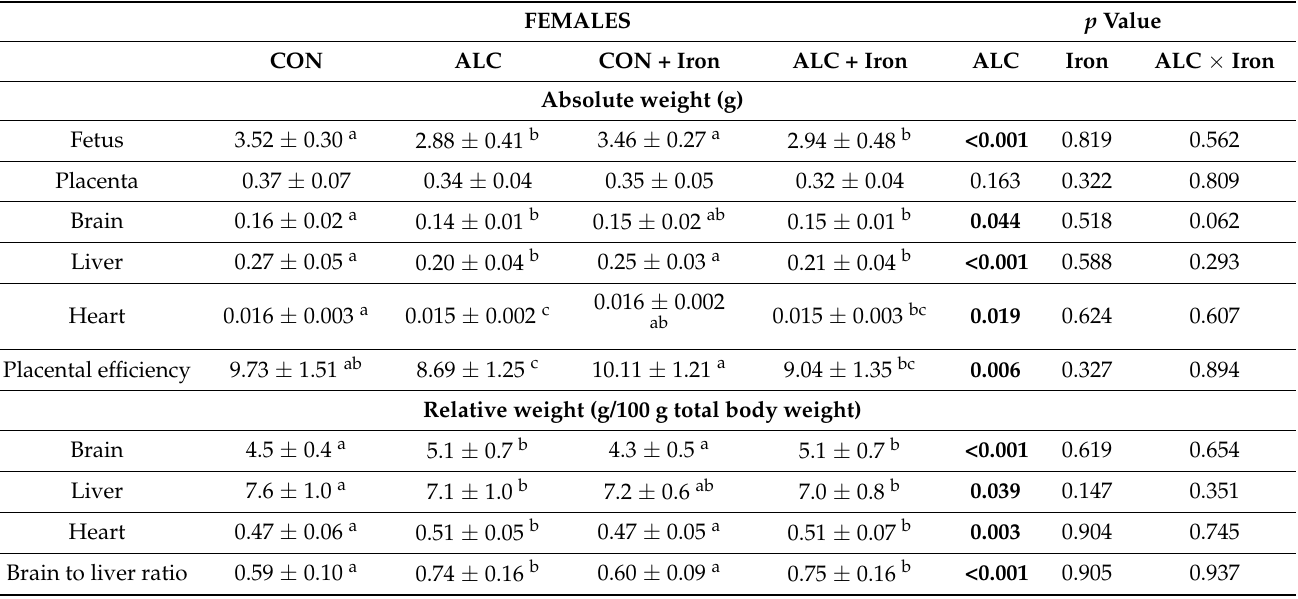
Table 3. In female fetuses, alcohol exposure reduced absolute fetal and organ weights and increased relative weights of brain and